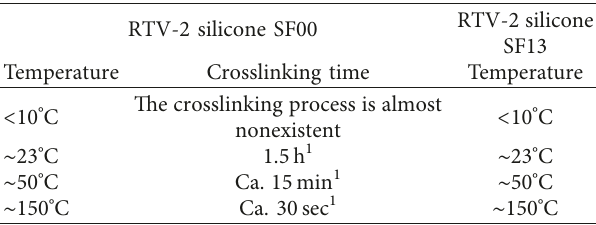
Figure 1: Typical torque M and phase angle δ curve at constant temperature for an elastomer compound [17]. Table 1: Crosslinking time as a function of temperature, SF00 and SF13